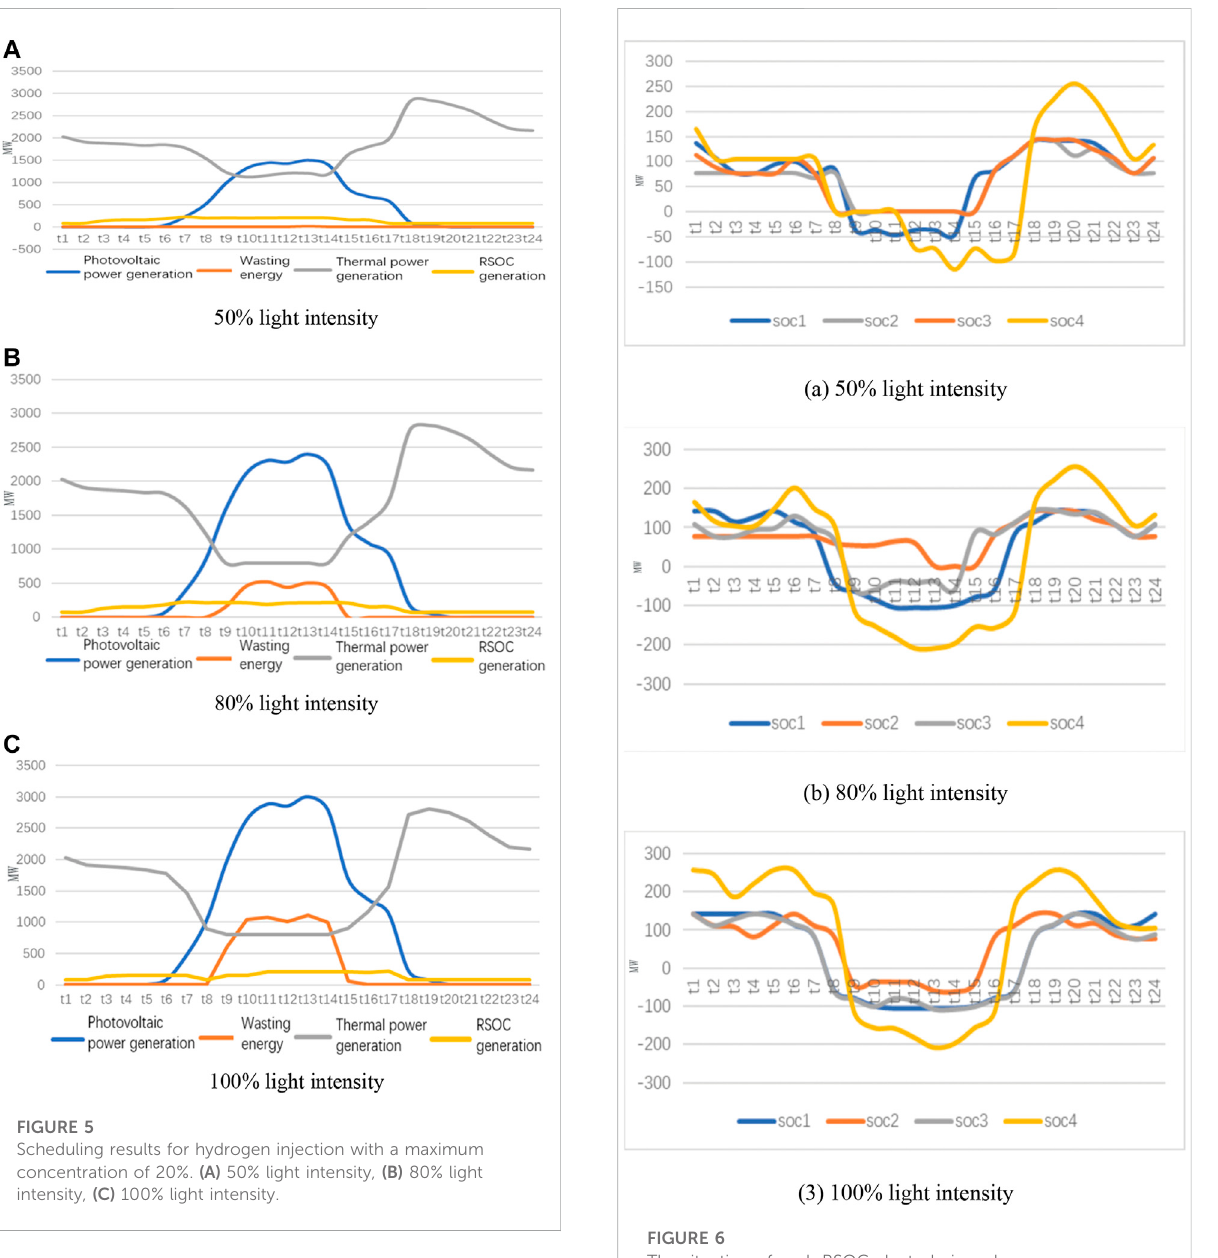
FIGURE 6 The situation of each RSOC electrolysis and